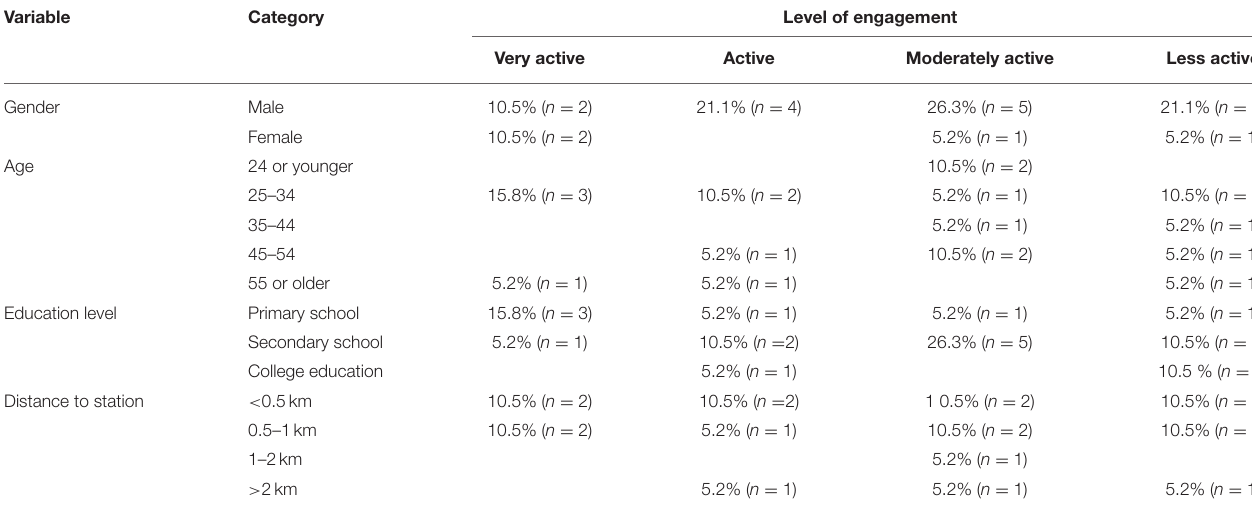
Variable Category Level of